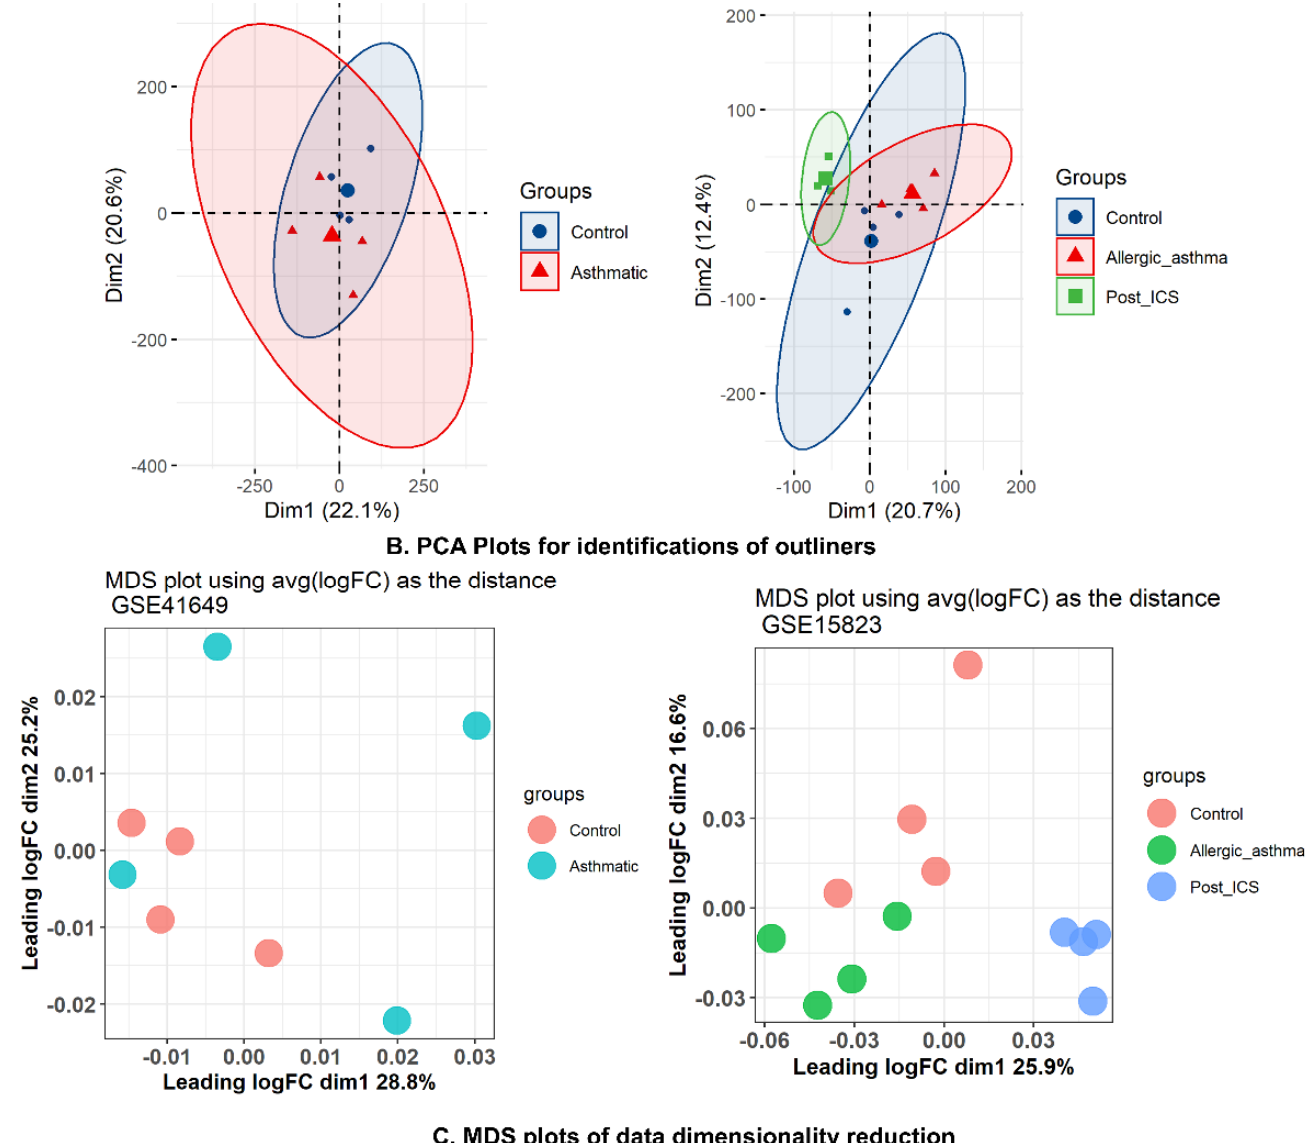
Figure 3. Standardization and preprocessing of datasets (GSE41649 and GSE15823) for WGCNA and DEG analysis. ( A ) Pearson correlation between datasets. ( B ) Principal component analysis (PCA) plot of datasets. ( C ) Dimension–reduction MDS plots for dissimilarities in datasets.